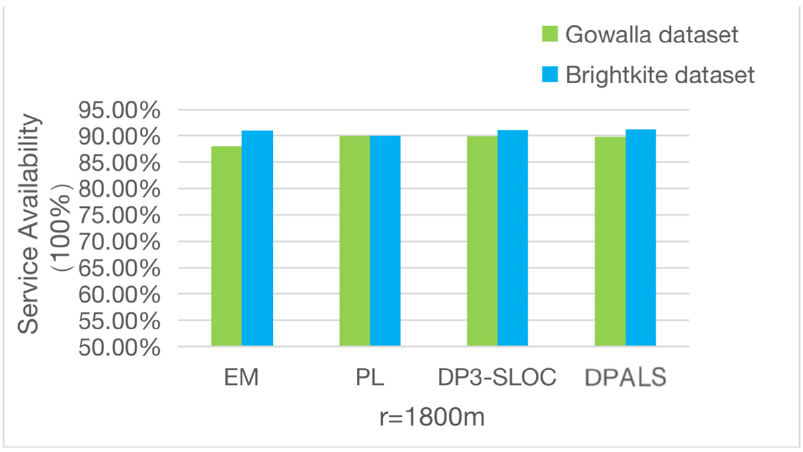
Figure 6. Comparison of quality of service at r = 1800 m.